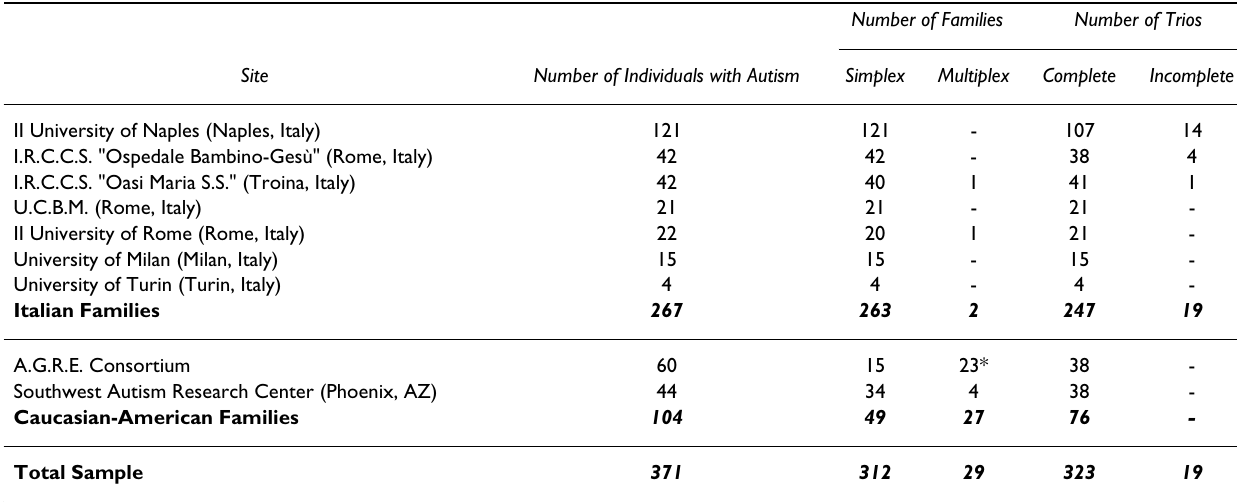
Table 1: Composition of the complete